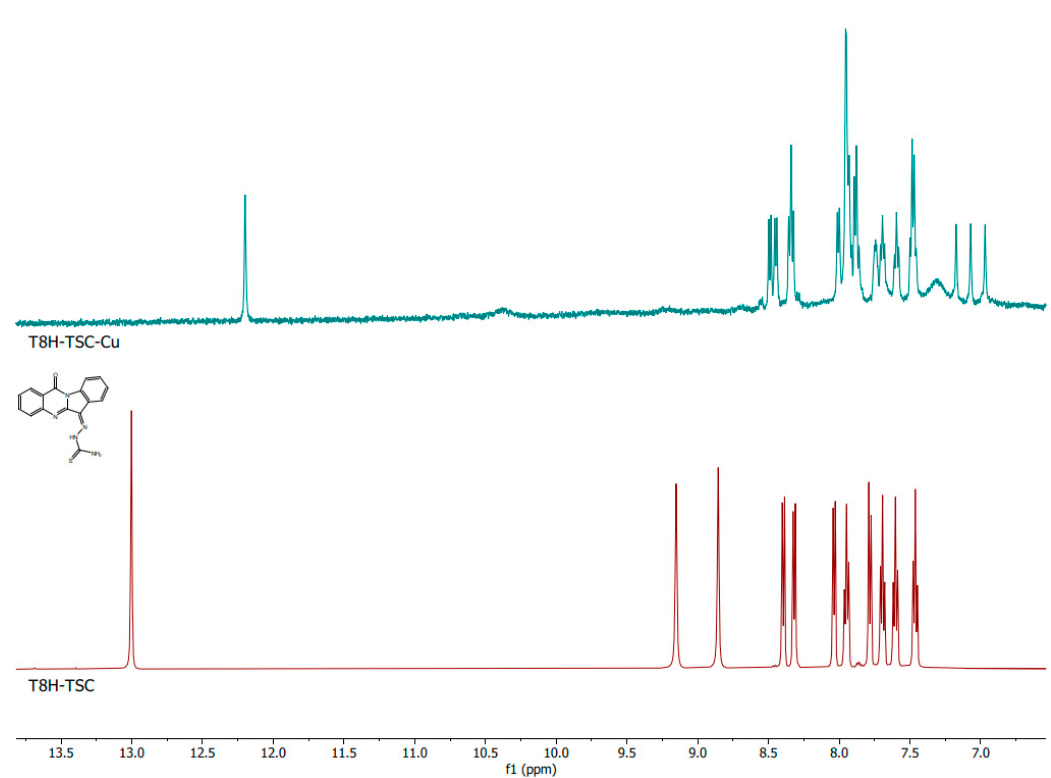
Figure 7. 1 H NMR spectra of the T8H-TSC (below; maroon colour) receptor and comparison with the corresponding complex with Cu(II) ions (above; teal colour).